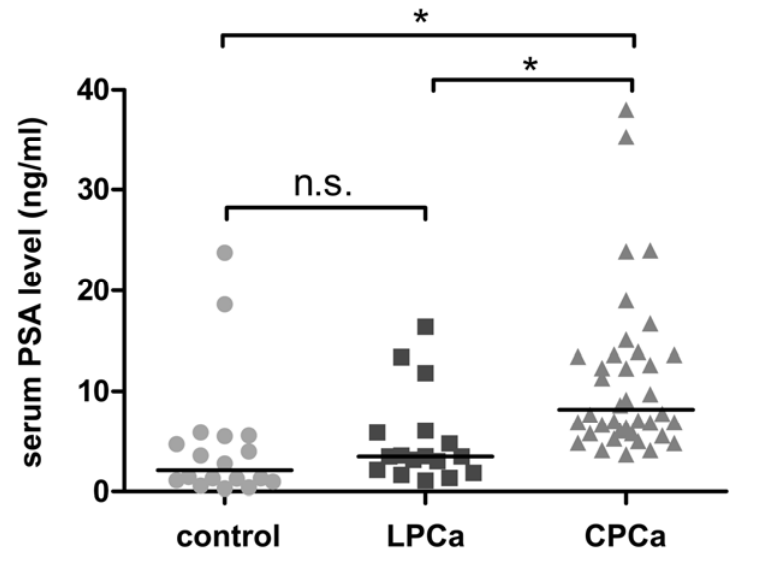
Figure 1. The distribution of serum PSA level in control group, latent prostate cancer group (LPCa), and clinical prostate cancer group (CPCa), respectively. The data were statistically analyzed by Mann-Whitney’s U test (see Materials and Methods). Asterisks indicate significant differences ( p < 0.0001). ‘n.s.’ indicates no significant